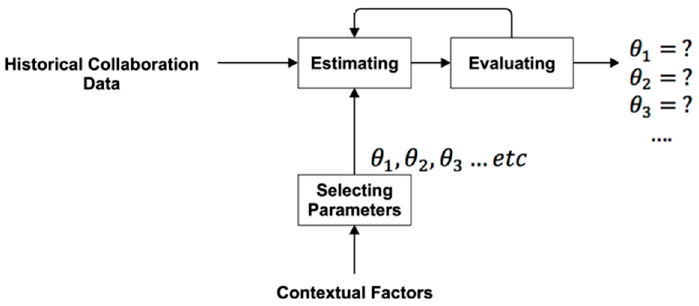
Figure 2. Estimating weights.